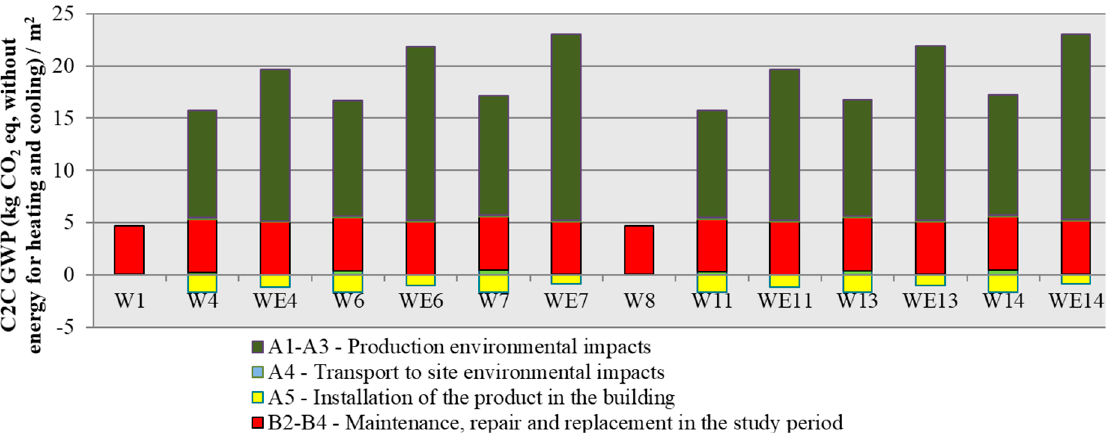
Figure 7. C2C Global Warming Potential (GWP, in kg CO 2 eq, without energy for heating and cooling)/m 2 of the external wall alternatives of ETICS with ICB and EPS.